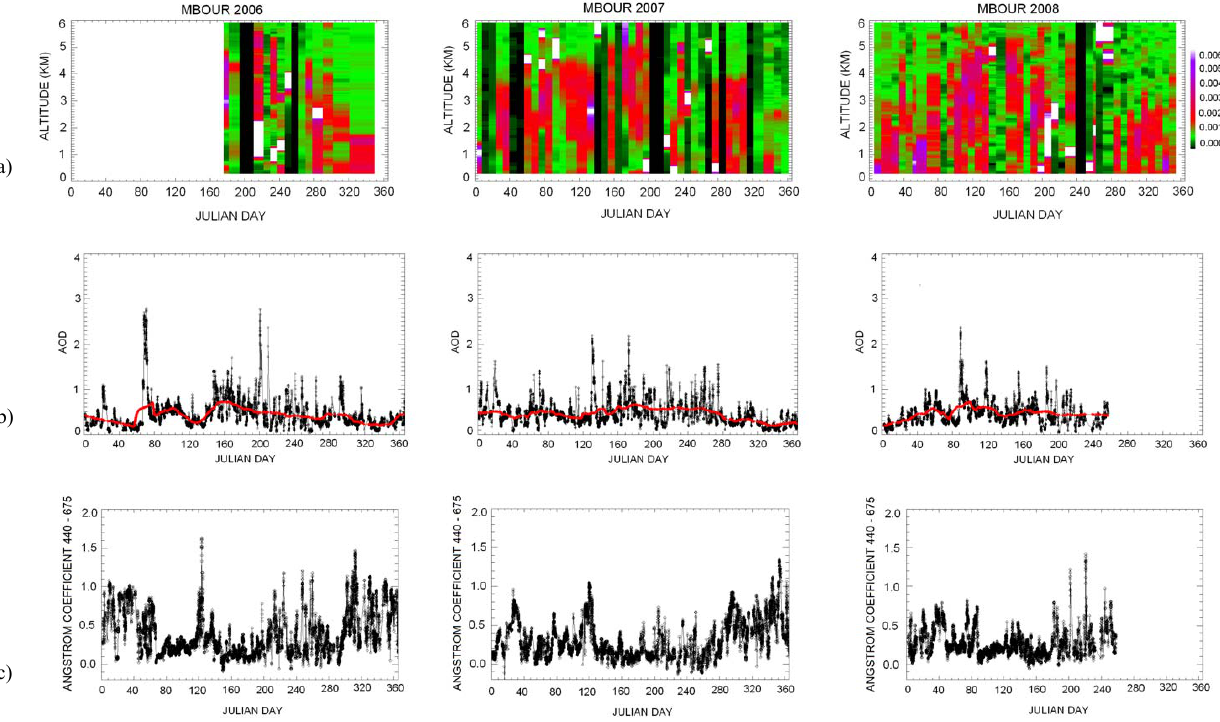
Fig. 7. Total attenuated backscatter (km − 1 sr − 1 ) obtained at 532nm from CALIPSO database (row a ) along with time series of aerosol optical depth (row b ) and ˚Angstr¨om coefficient (row c ) estimated at 532nm from AERONET database for year 2006 (left), 2007 (middle) and 2008 (right) at Dakar site. The red line in (row b ) represents a one-month running average of the AOD time